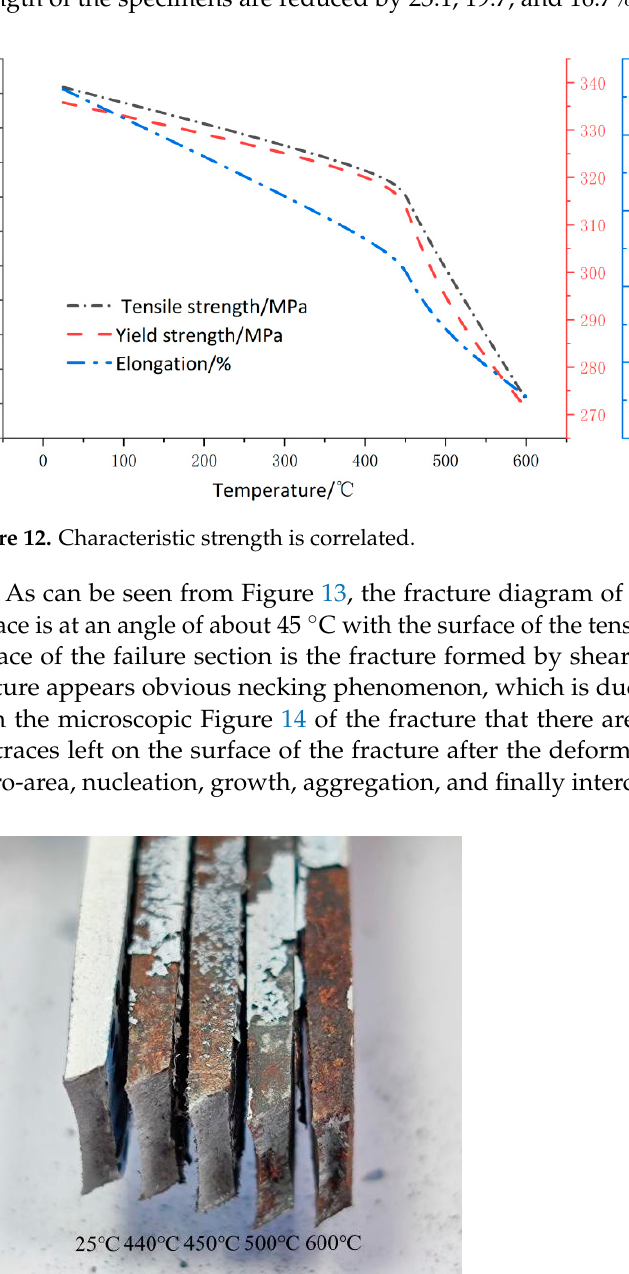
Figure 11. True stress–strain diagram of specimens under uniaxial tension.